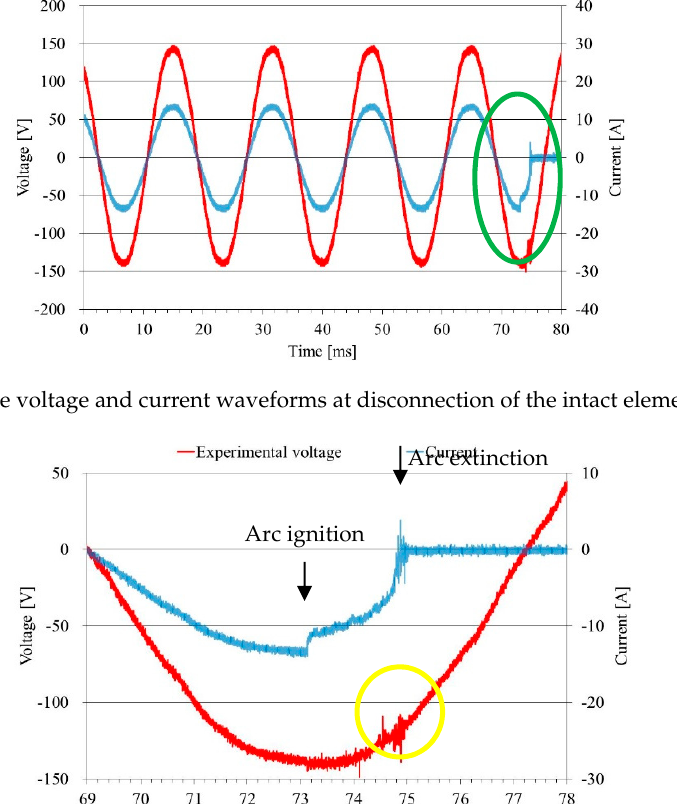
Figure 19. Magnified view of the part surrounded by a green ellipsoid in Figure 18.